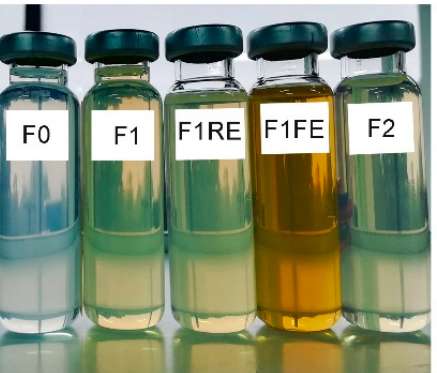
Figure 5. Visual appearance of the selected nanoemulsion samples prepared for in vitro and in vivo investigations: F0 (blank nanoemulsion without antioxidants), F1 (RO as lipophilic antioxidant, prepared with cosurfactant 1), F1 red raspberry (RE) and F1 French oak (FE) (with RO and additional hydrophilic antioxidants—RE, and FE, respectively, at 5 wt% relative to nanoemulsion total mass), and F2 (prepared with RO and cosurfactant 2, without additional hydrophilic antioxi- dants). Table 2. Z-average droplet size (Z-ave) and polydispersity index (PDI) of the selected